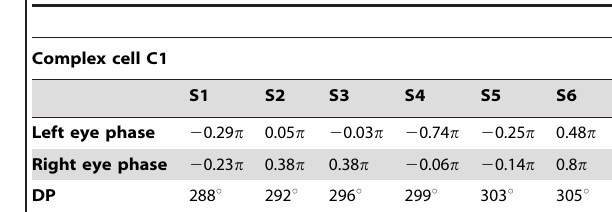
Table 1. Modeled simple cell 1D RF profile phases for complex cell C1.